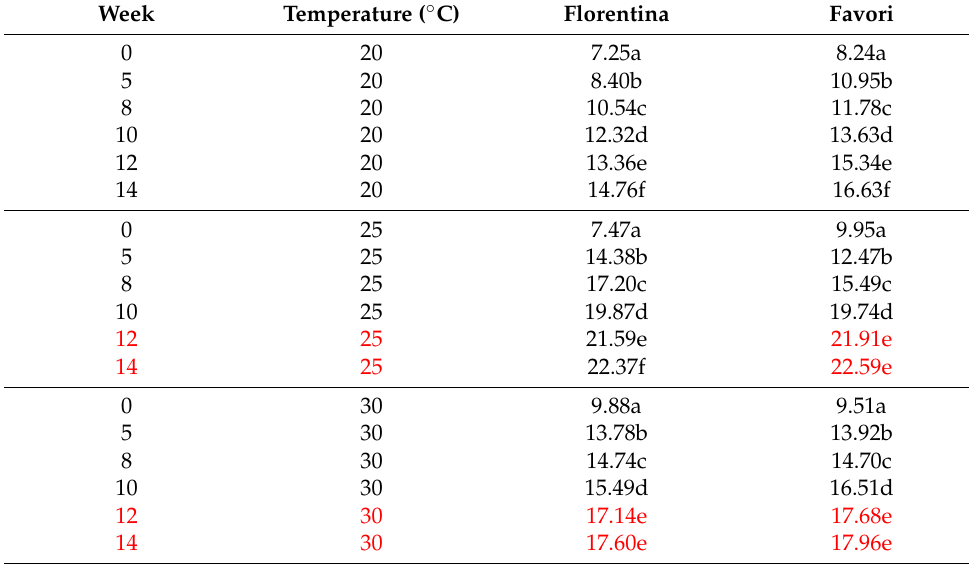
Table A1. Mixed effects linear regression model for height measurements taken during W0, W5, W8, W10, W12, and W14 for the three temperature treatments, 20, 25, and 30 ◦ C in SD for ‘Florentina’ and ‘Favori’, respectively. Sidak pairwise comparison shows that similar alphabet indicates no significant difference between weeks. The values marked in red show consecutive non-significant difference.